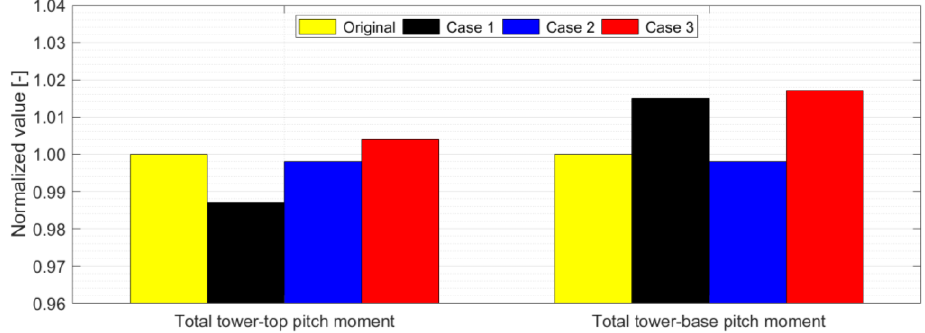
Figure 17. Normalized values of tower-top and tower-base pitch moments.